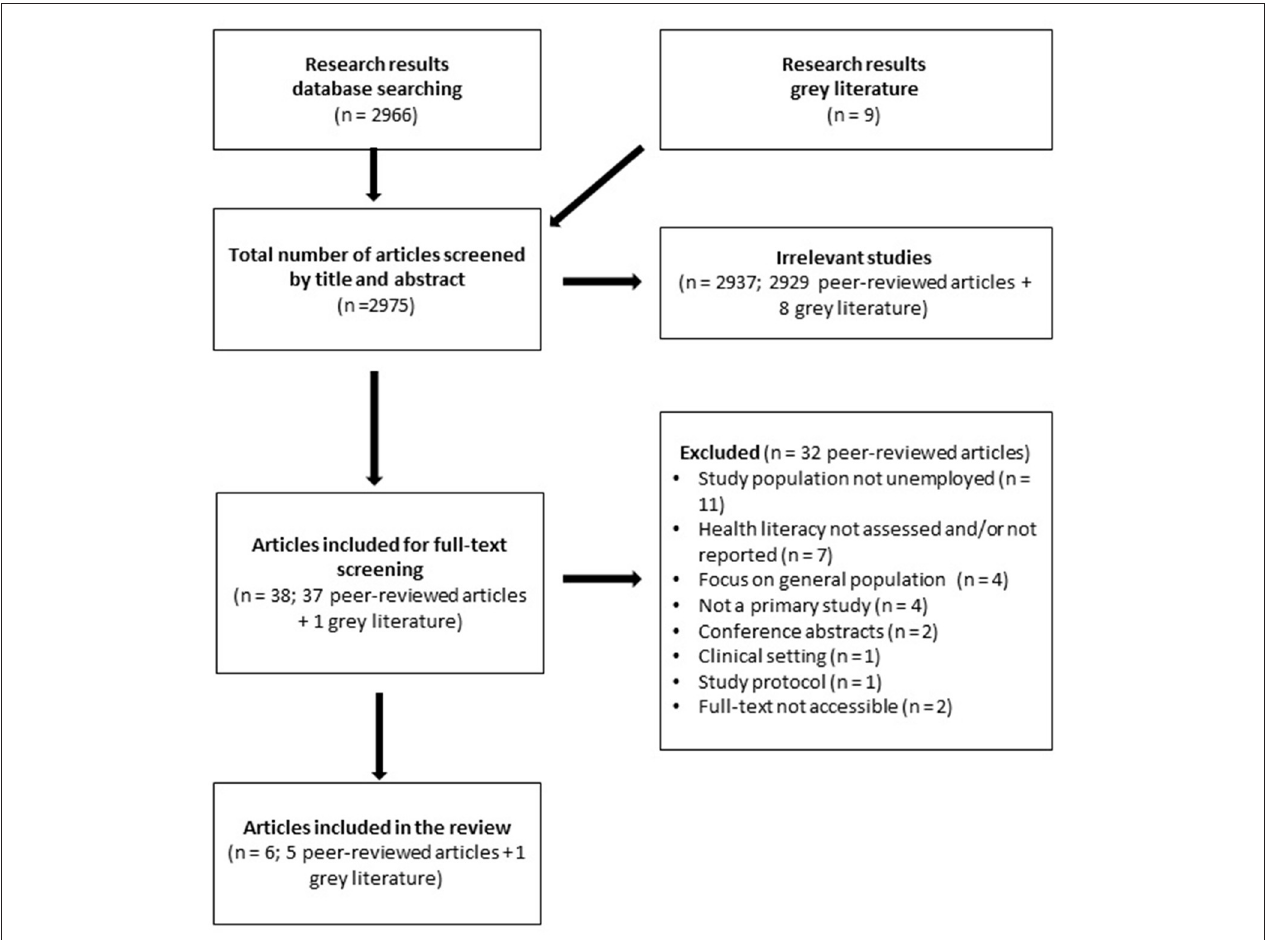
FIGURE 1 | PRISMA flowchart showing selection process of publications included in the